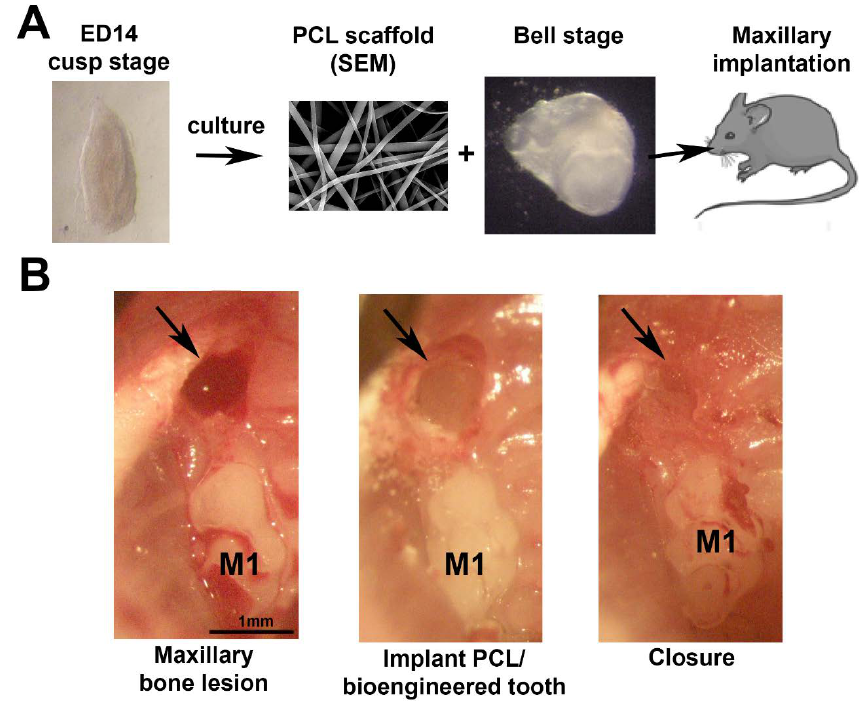
Figure 1. Study protocol. ( A ) Bioengineered tooth (bell stage) preparation and implantation in the maxillary bone. ( B ) Stages of the microsurgery: maxillary bone lesion obtained with a dental bur (500 μm), implantation of the PCL membrane with the bioengineered tooth, and closure of the gingiva with biological glue. ED14 = Embryonic Day 14, M1 = first molar, SEM = scanning electronic microscopy.